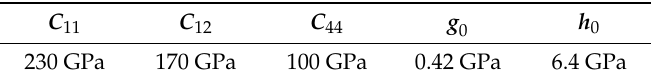
Table 1. The elastic constants ( C 11 , C 12 , and C 44 ), critical resolved shear stress ( g 0 ), and strain hardening modulus ( h 0 )